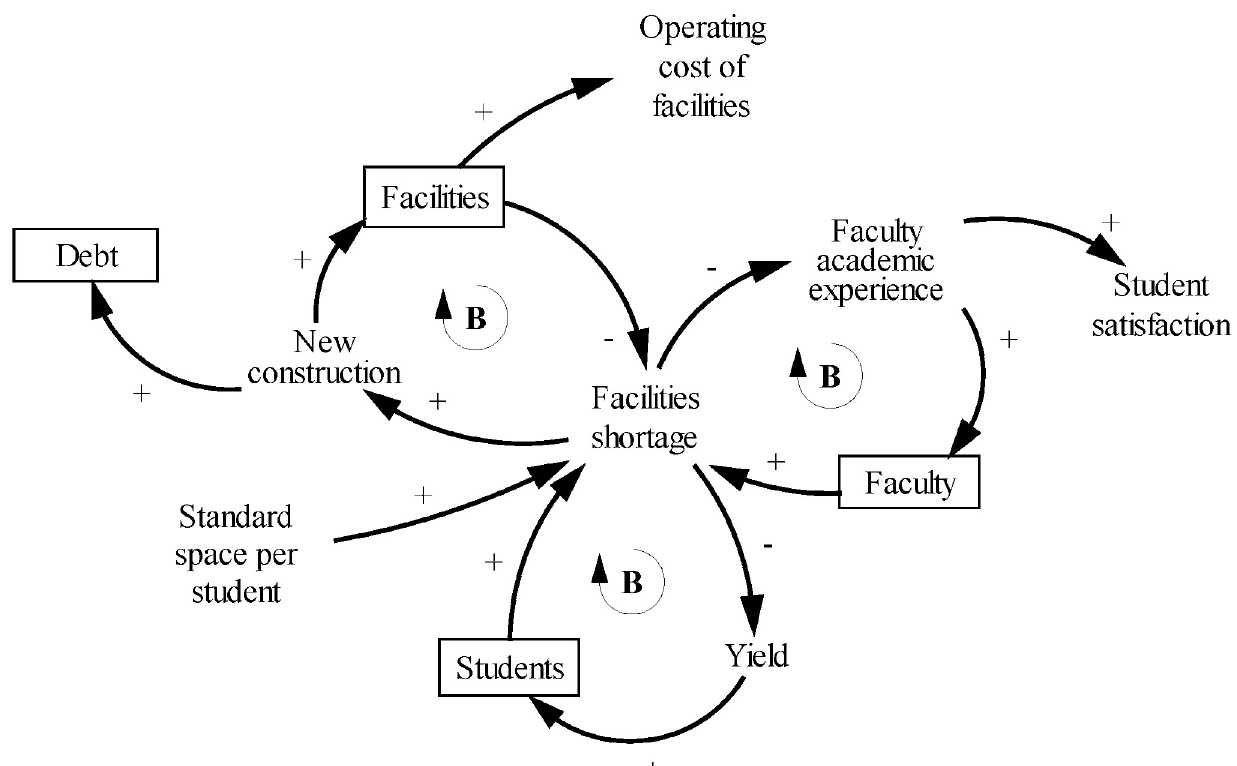
Fig 4. Causal structure of the facilities sector.